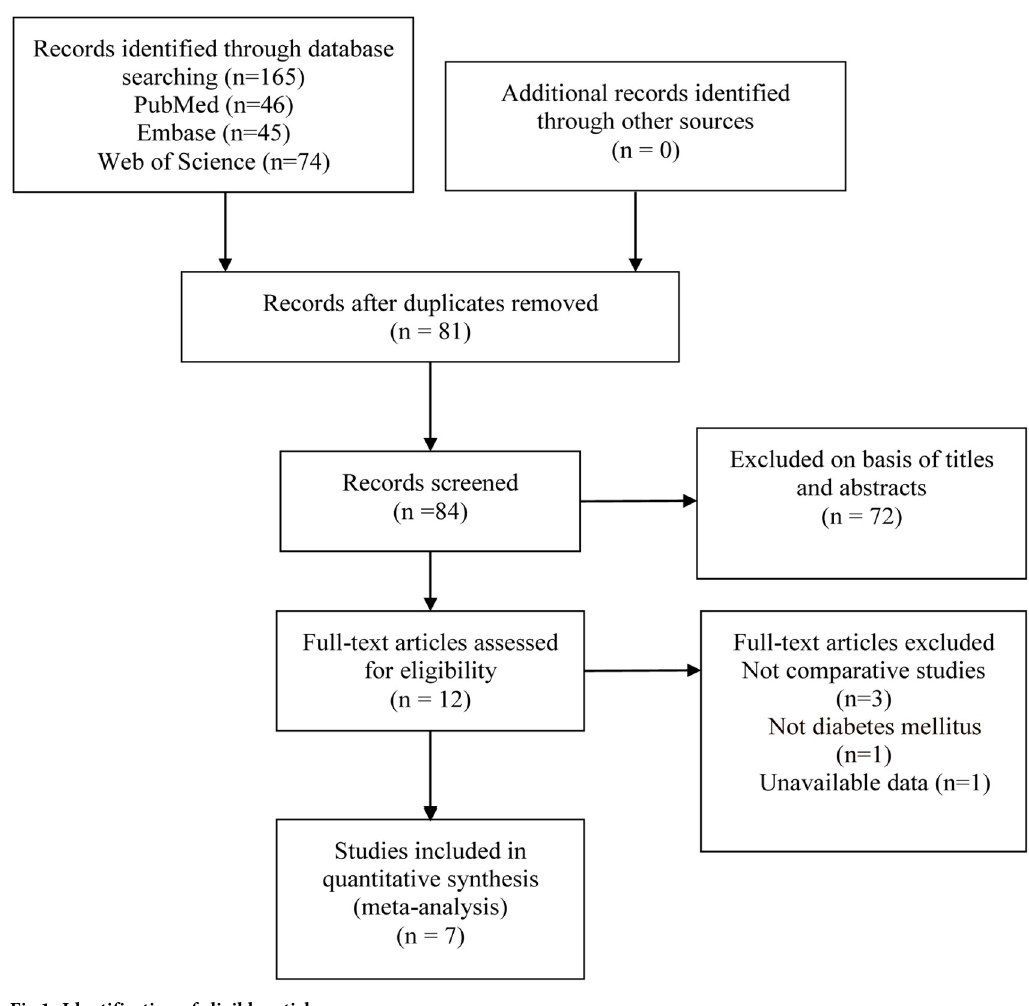
Fig 1. Identification of eligible